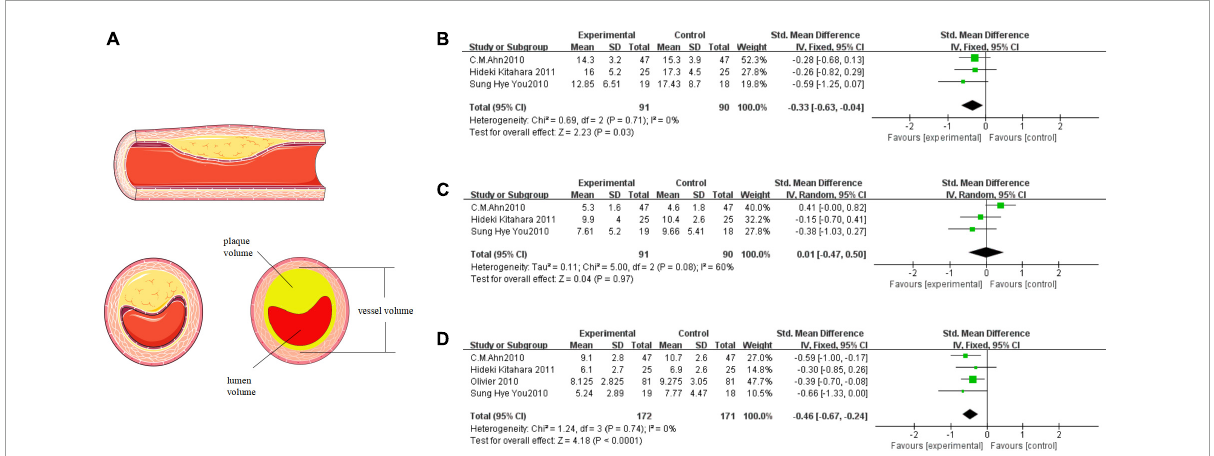
FIGURE3 TZDs slowed the progression of plaque attachment on the vascular endothelium. (A) The relationship above vessel volume, lumen volume, and plaque volume; the materials in the figure were provided by Servier Medical Art (https://smart.servier.com) under a CC BY 3.0 license. (B) Effect of the TZDs on the vessel volume (mm 3 /mm). (C) Effect of the TZDs on the lumen volume (mm 3 /mm). (D) Effect of the TZDs on the plaque volume (mm 3 /mm).